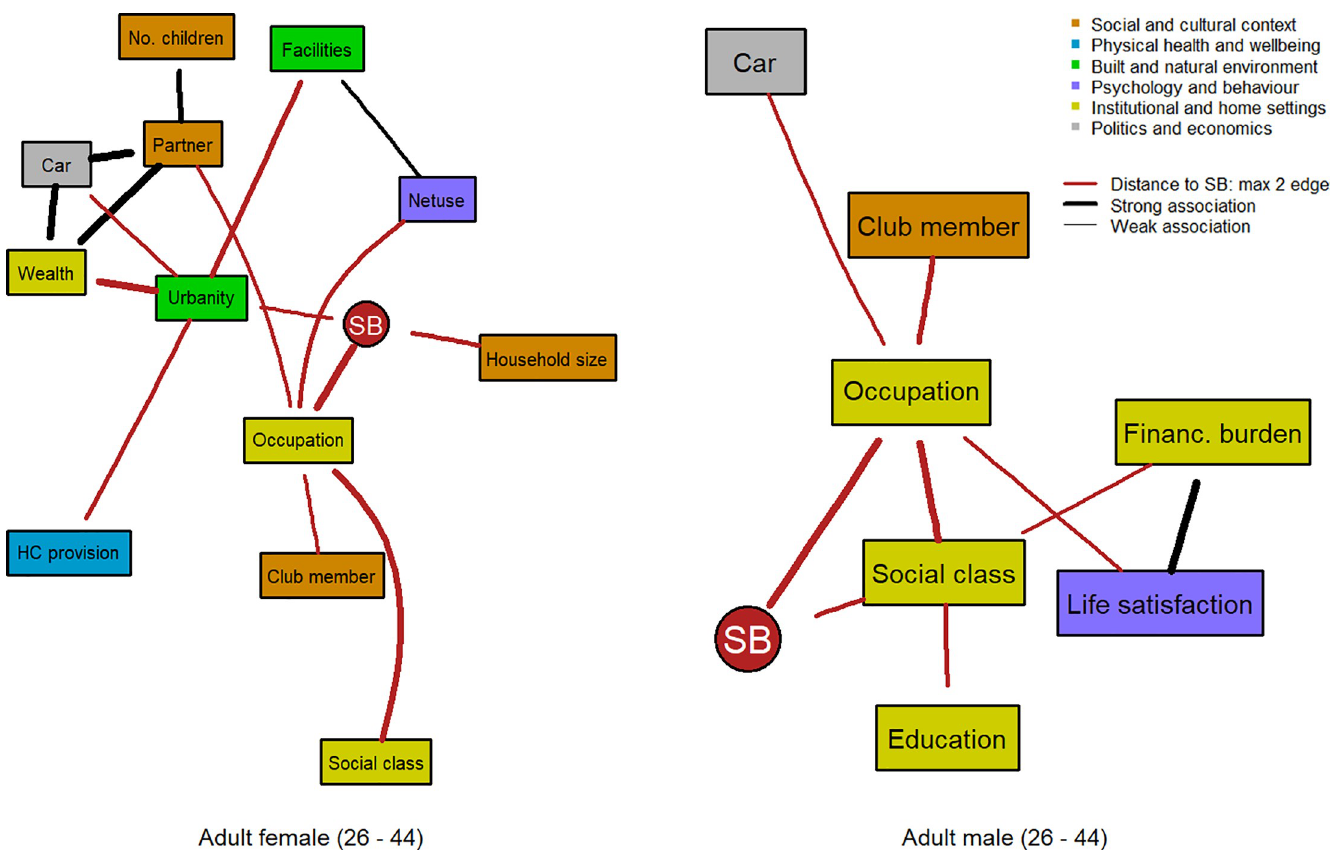
Fig 3. Factors linked to SB within two edges distance in the subgraphs for adult females (3a: left; N = 3,872) and adult males (3b: right; N = 3,244).